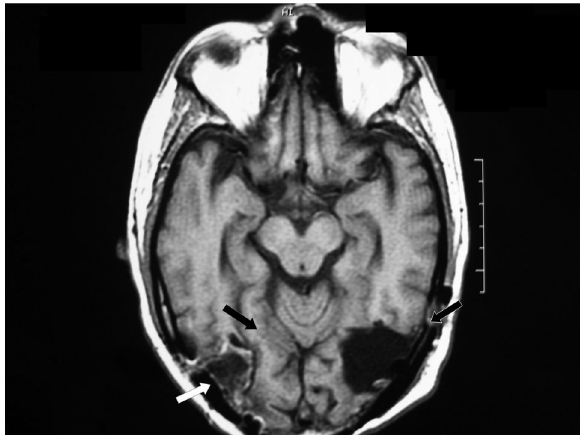
Figure 2. Postoperative MRI: To the right, white arrows showing involvement of inferior and occipital gyrus, with black arrows showing relative preservation of the right fusiform gyrus. To the left the black arrows show involvement of inferior and medial occipital gyrus and